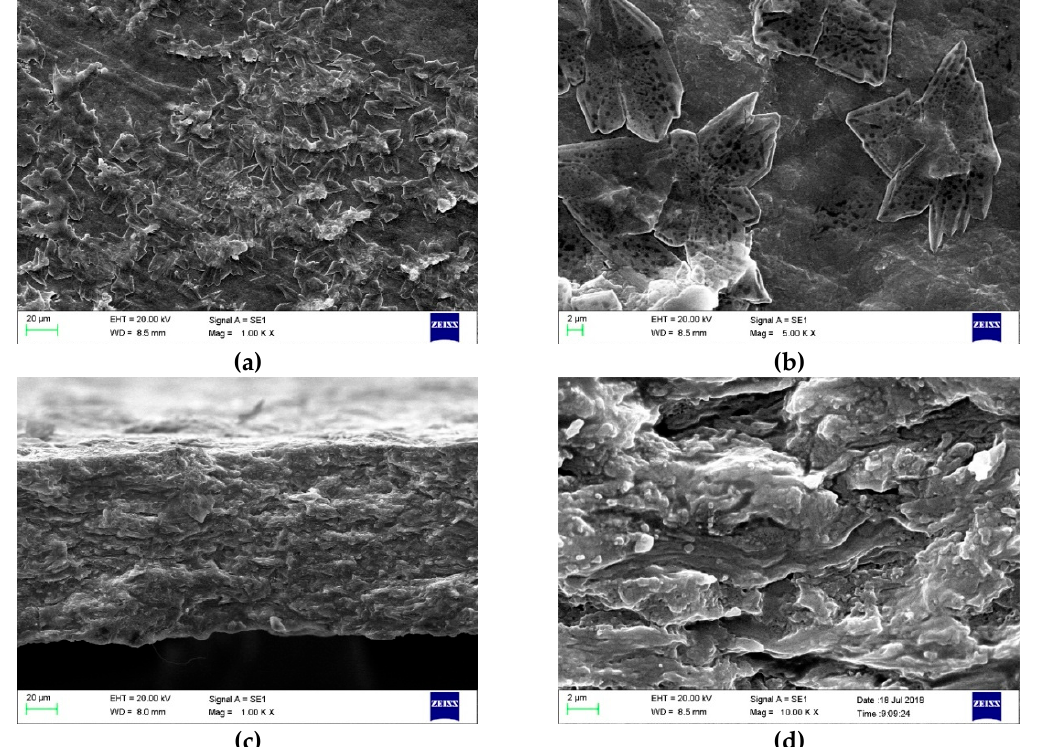
Figure 4. FE-SEM micrographs of film surfaces with a magnification of 1.00 K × ( a ) and 5.00 K × ( b ) and cross-sectional images with a magnification of 1.00 K × ( c ) and 10.00 K × ( d ) containing the highest concentration of sugar (14%) prepared according to the sol-gel-ma method (maleic anhydride and glycerol concentrations were 0.39% and 7%,